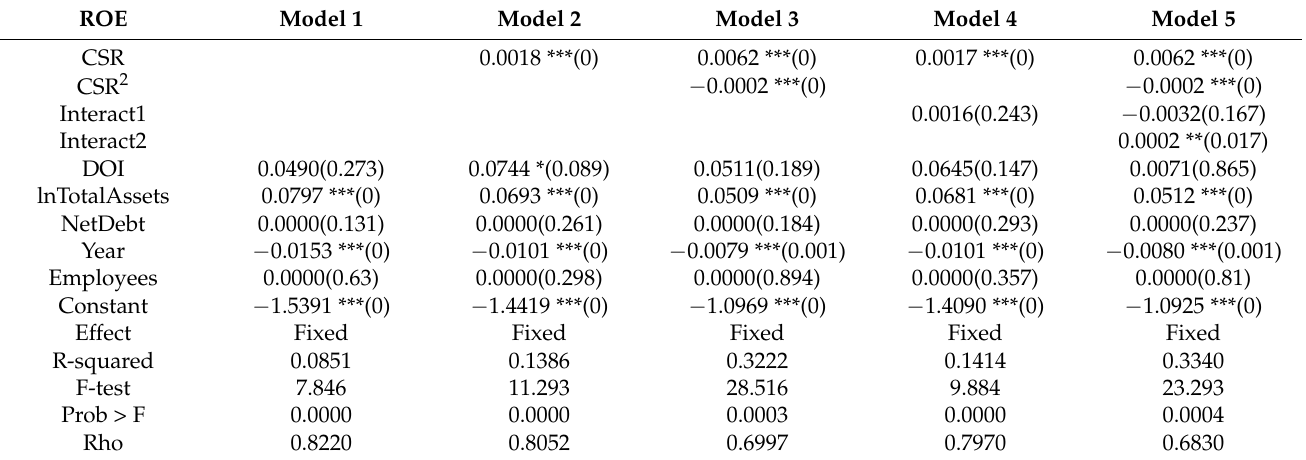
Table 3. Regression results.